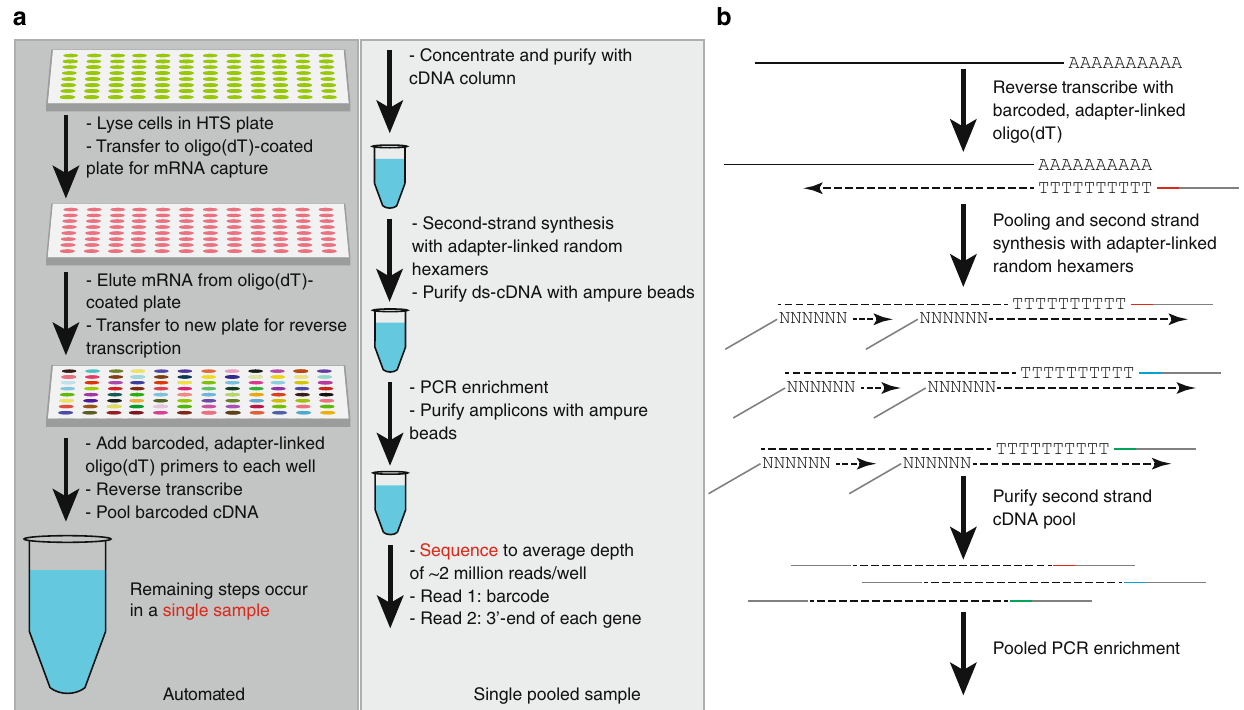
Fig. 1 Schematic illustration of PLATE-Seq work fl ow. a After conducting a screen in multi-well plates, we lyse the cells and capture mRNA from the cell lysate using an oligo(dT)-coated capture plate. The puri fi ed mRNA is then reverse transcribed with barcoded, adapter-linked olig(dT) primers and the resulting cDNA is pooled. All of these steps are automated. The remaining steps, which take place on a single pooled sample, are conducted manually and include cDNA puri fi cation, second-strand synthesis, and PCR enrichment. b Molecular-level schematic for constructing 3 ′ -end PLATE-Seq libraries. After reverse transcription with oligo(dT), second-strand synthesis of the pooled cDNA is accomplished using random hexamer primers prior to PCR enrichment of the barcoded